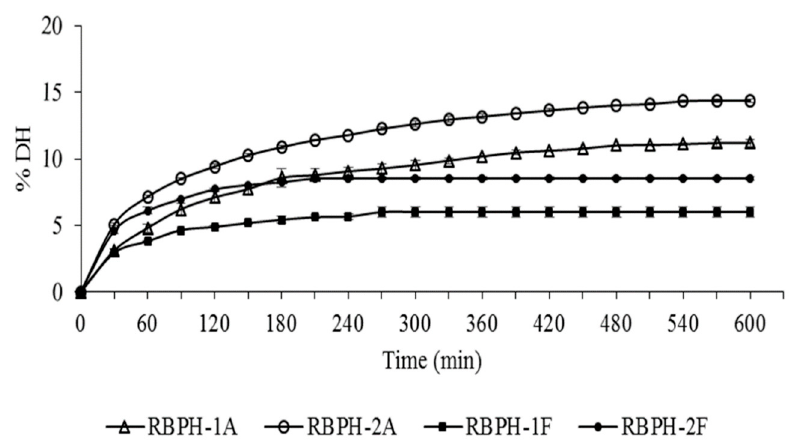
Figure 1. Degree of hydrolysis (%DH) of defatted rice bran protein concentrates RBPC-1 and RBPC-2 incubated with alcalase or flavorzyme enzymes. RBPH-1A: concentrate DRBPC-1 hydrolyzed with alcalase; RBPH-2A: concentrate DRBPC-2 hydrolyzed with alcalase; RBPH-1F: concentrate DRBPC-1 hydrolyzed with flavorzyme; RBPH-2F: concentrate DRBPC-2 hydrolyzed with flavorzyme. Each point of the curve shows the means ± standard deviation of three measurements.